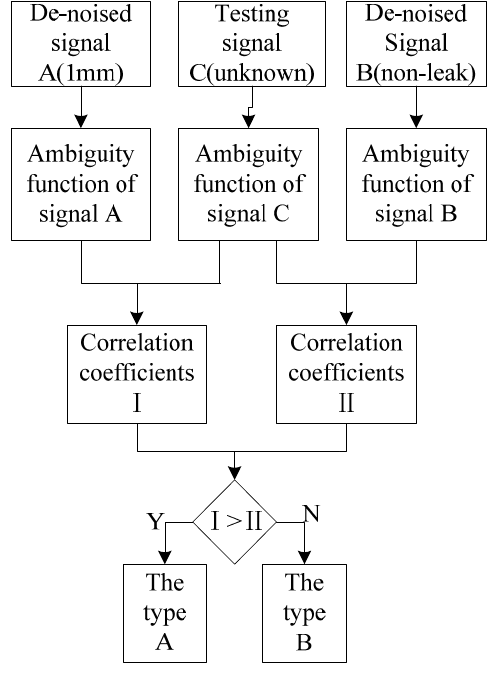
Figure 3. ACC flowchart.